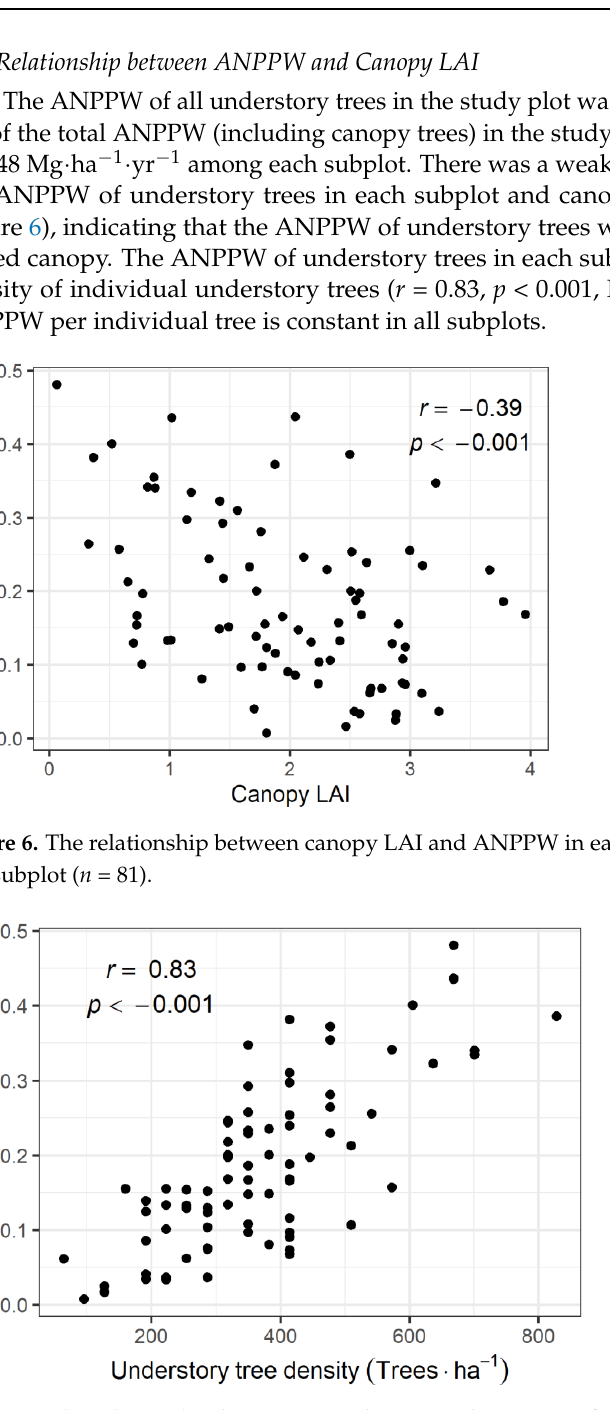
Figure 7. The relationship between tree density and ANPPW of understory trees in each subplot. Each point indicates one subplot (n = 81).